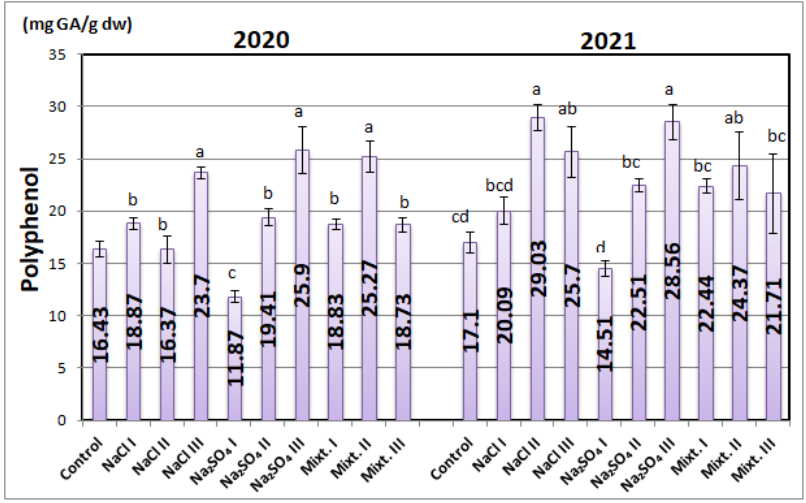
Figure 7. Polyphenol content of N. cataria L. studied variants with significant differences at 0.001 level indicated with letters.